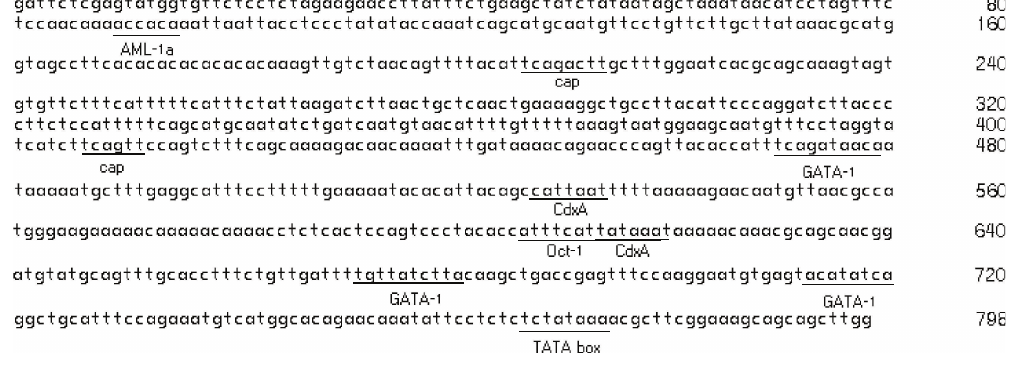
indel were identified in 3671 bp of the dGHRL gene, while 48 SNPs (35 transitions and 13 transversions) and 5 indels were found in 3567 bp of the dGHSR gene (Table 3).